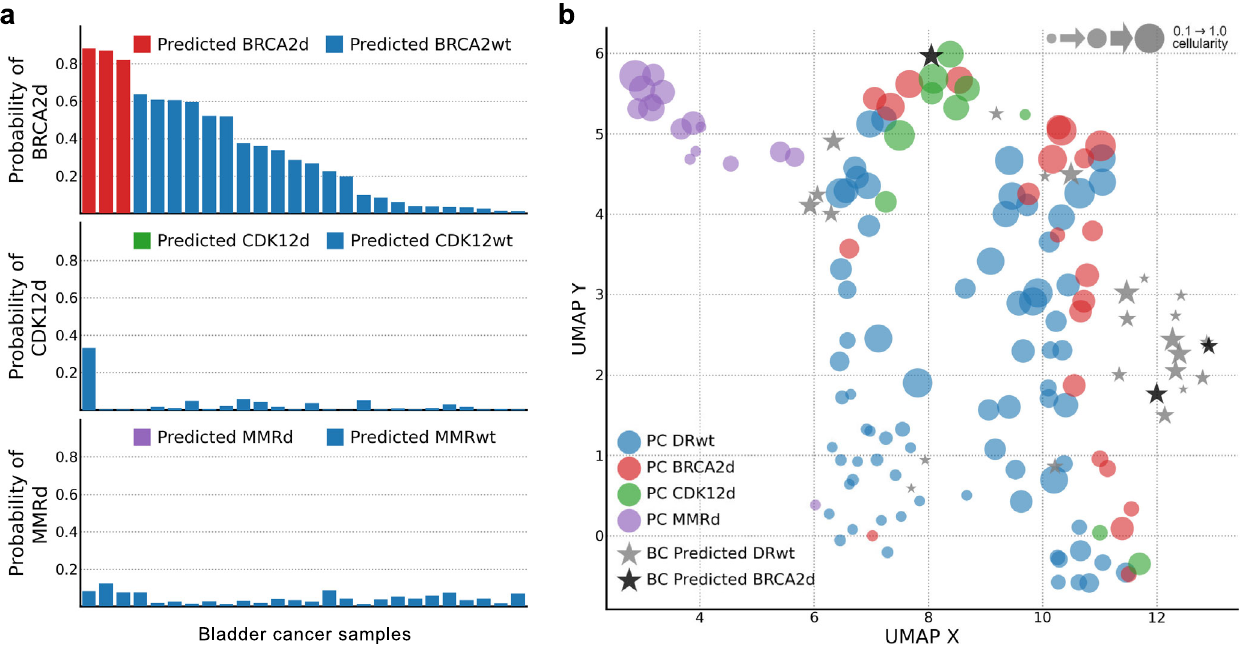
Fig. 4 DARC sign models applied to metastatic bladder cancer ctDNA samples. a Predicted probabilities of class membership (using the models developed for metastatic prostate cancer) for 26 metastatic bladder cancer whole-exomes. All samples are column consistent between each row, and sorted by probability of BRCA2d class membership. b 2-dimensional UMAP representation including both metastatic prostate (circular points) and bladder samples